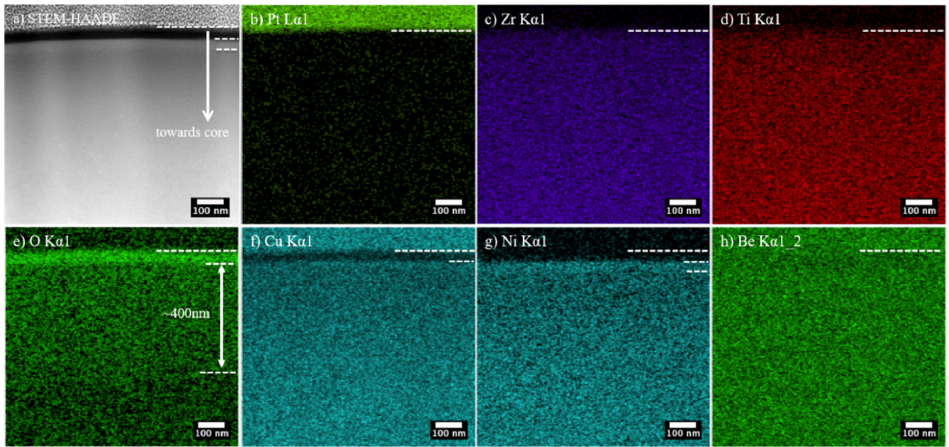
Figure 4. STEM ‐ EDS analysis for 350 ‐ 40, a ) high ‐ angle ‐ annular ‐ dark ‐ field (HAADF) image taken Figure 4. STEM-EDS analysis for 350-40, ( a ) high-angle-annular-dark-field (HAADF) image taken under scanning transmission electron microscopy (STEM) and b – h ) STEM ‐ EDS maps for the regions under scanning transmission electron microscopy (STEM) and ( b – h ) STEM-EDS maps for the regions shown in Figure 4a for element. shown in Figure 4a for element.